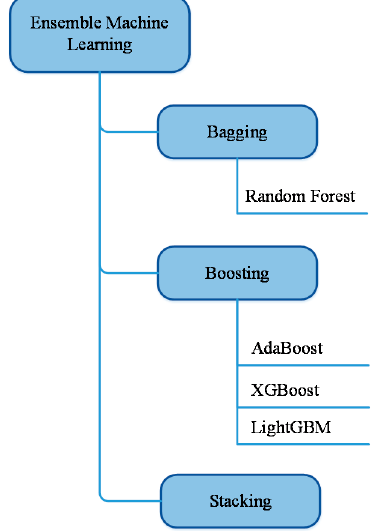
Figure 1. Ensemble machine learning framework.